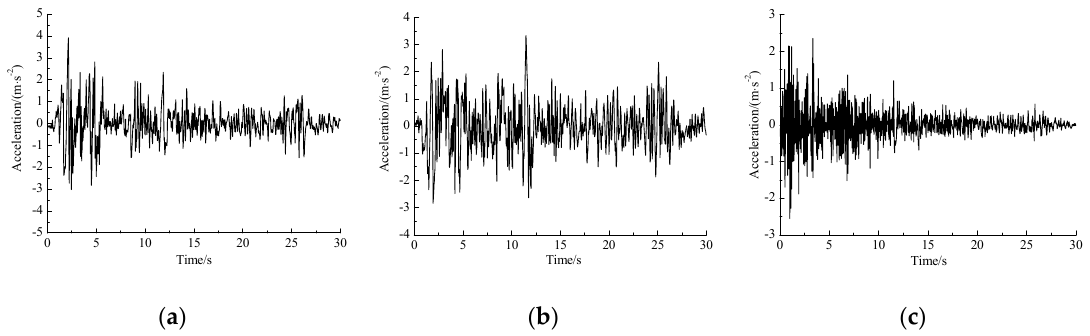
Figure 2. Acceleration time-history curves of the El Centro ground motion: ( a ) X-direction; ( b ) Y-direction; ( c ) Z-direction.